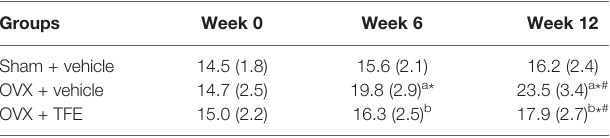
TABLE 3 | Changes in marrow fat fraction in three groups of rats.